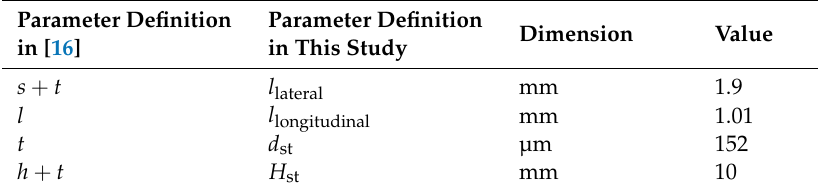
Figure A2. Definition of geometrical parameters for an offset strip fin heat exchanger [16]. Table A3. Geometrical parameters of the offset strip fin heat exchanger with nomenclature from [16] and nomenclature used within this study.